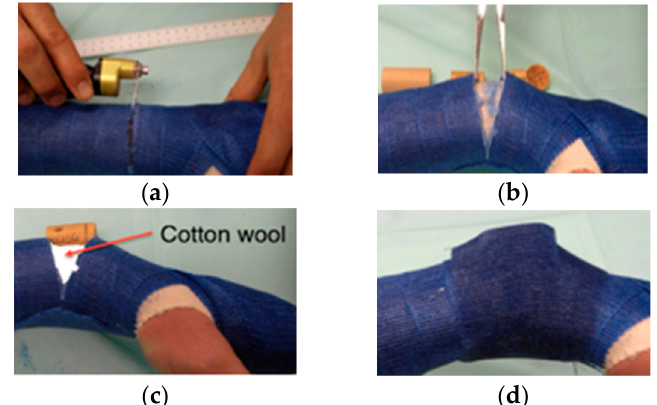
Figure 2. Cast wedging of a distal forearm fracture. ( a ) Wedging position is marked, and the cast is cut approximately 2/3 of the circumference using an oscillating saw. ( b ) Cast can now be opened with a clamp until the desired correction is obtained. ( c ) Position is fixed using a placeholder (i.e., piece of cork), and cotton wool is inserted at the wedging site to serve as a cushion. ( d ) Cast is stabilized with additional circular layers of synthetic cast.